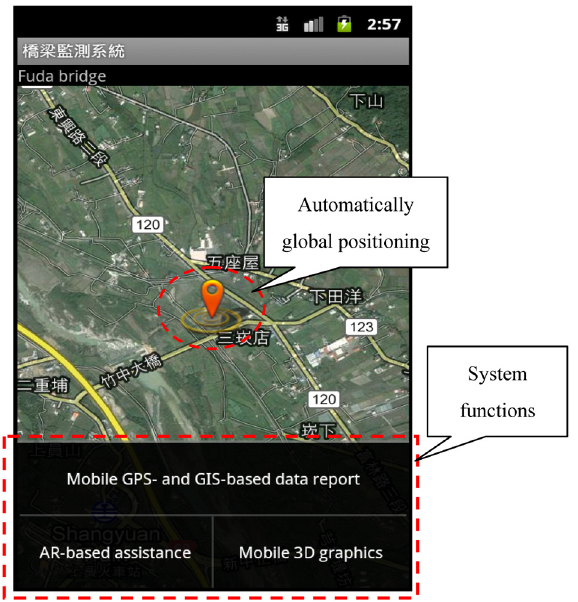
Fig. 4. A screenshot of the mobile disaster response